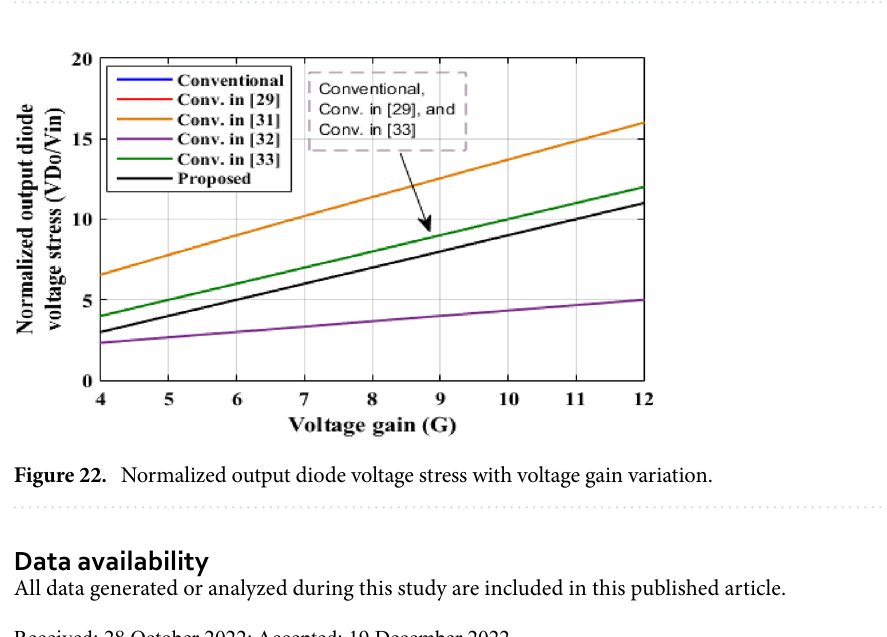
Figure 21. Normalized switch voltage stress with voltage gain variation.